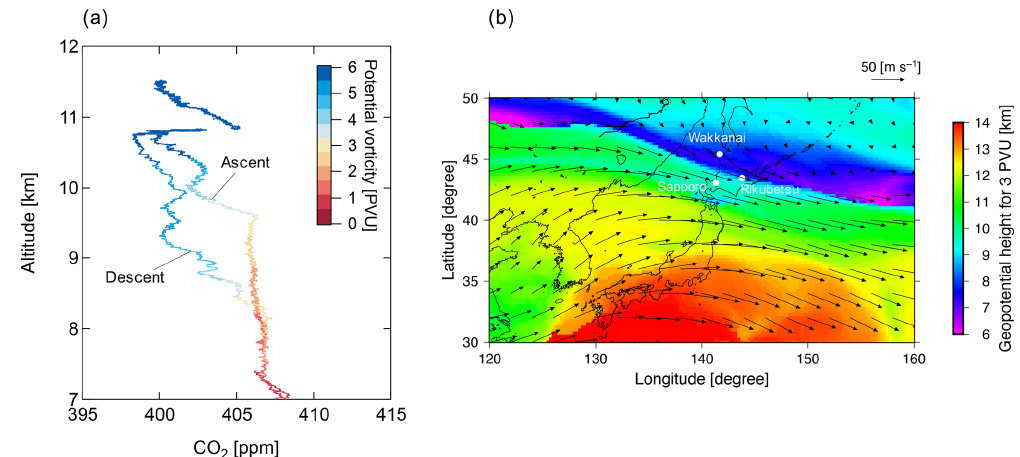
Figure 2. (a) The CO 2 profiles above 7km over Rikubetsu. Colors denote the potential vorticity values from ERA5 (see text for details). (b) The ERA5 geopotential height (color scale) and winds (vectors) at the 3PVU level on 27 April 2016, 02:00UTC, are shown. White dots indicate the locations of Rikubetsu and two radiosonde stations in Hokkaido operated by the Japan Meteorological Agency (Sapporo and